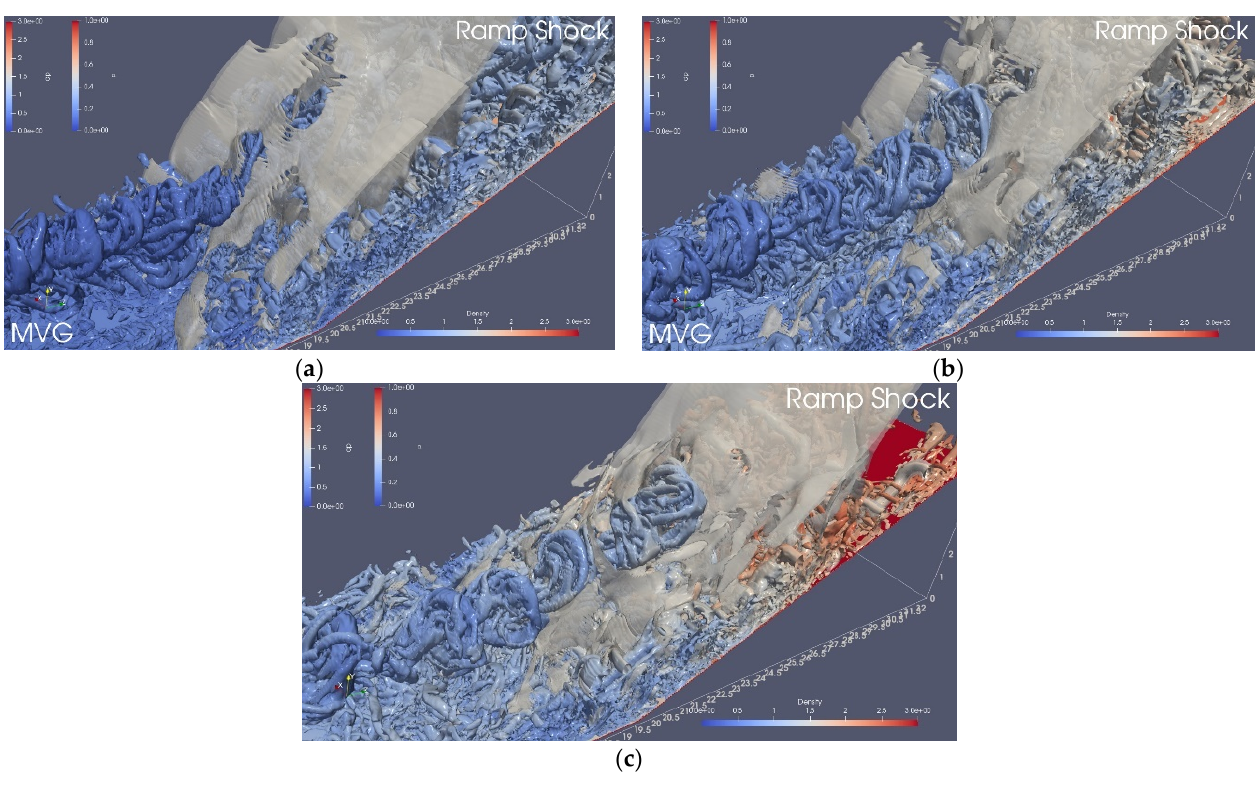
Figure 4. SWBLI at the ramp corner ( a ) Ma 1.5 ( b ) Ma 2.0 ( c ) Ma 2.5.